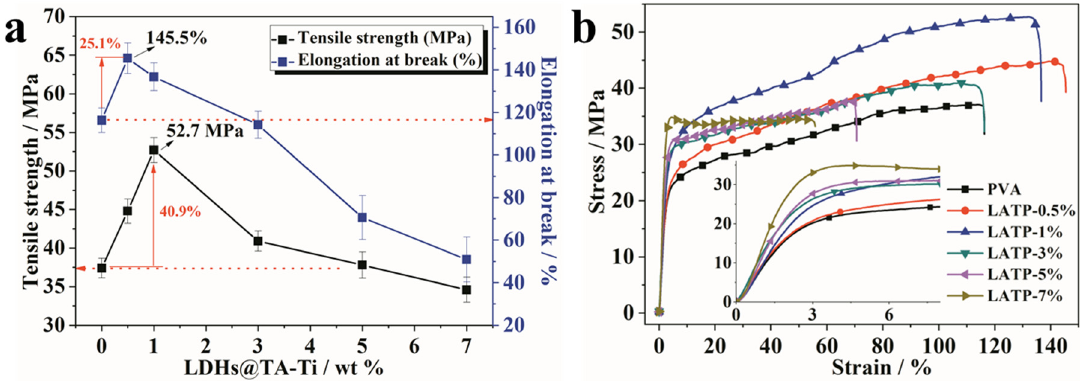
Figure 8. ( a ) Mechanical properties and ( b ) stress–strain curves of LDHs@TA-Ti/PVA